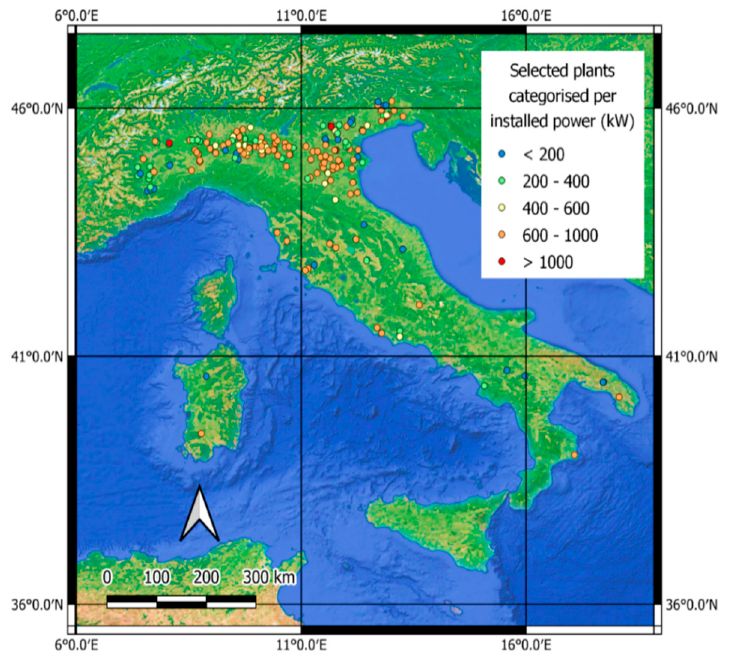
Figure 2. Map of biogas plants in Italy. Table 3. Frequency of sampled digesters split by power